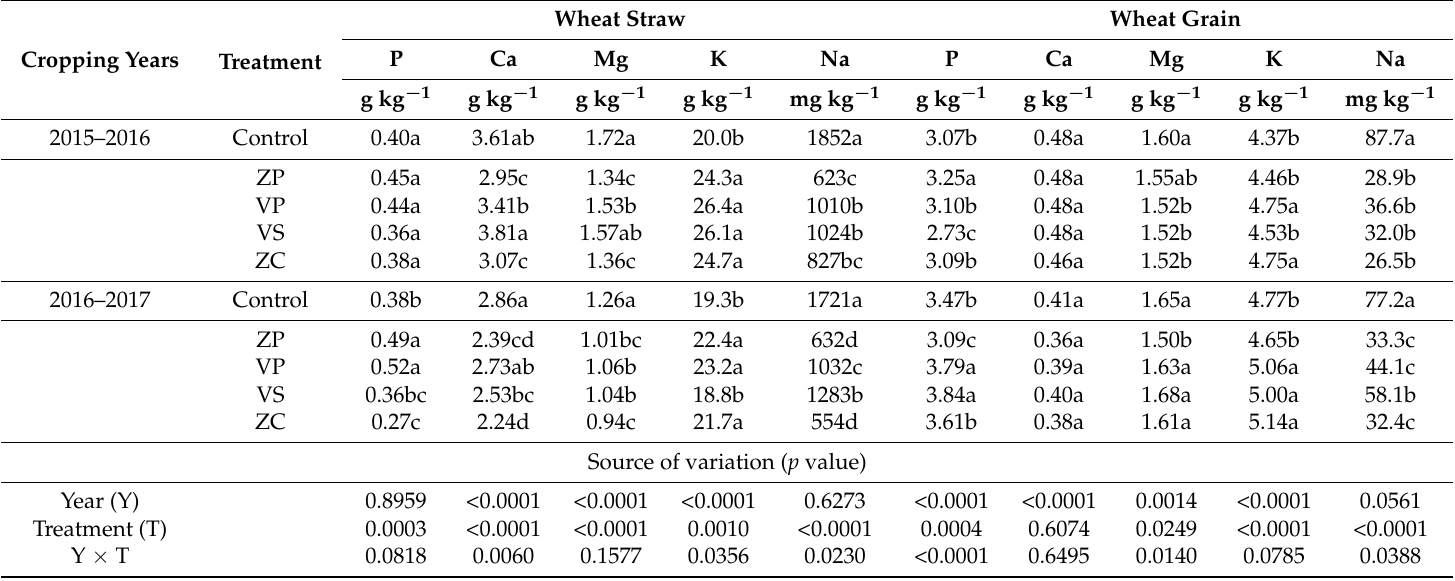
Table 4. Effects of amendment treatment and year on the chemical composition of wheat straw and